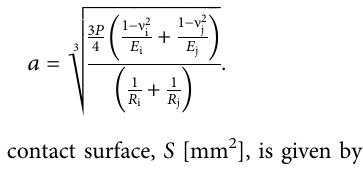
Frontiers in Chemical Engineering |